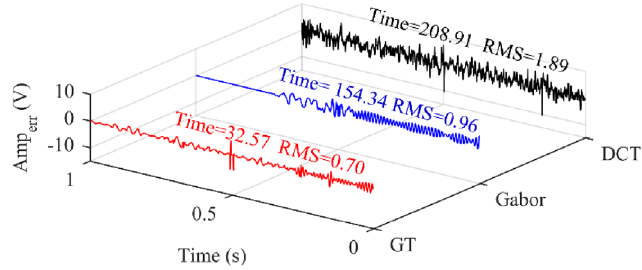
Figure 8. Dictionary testing.